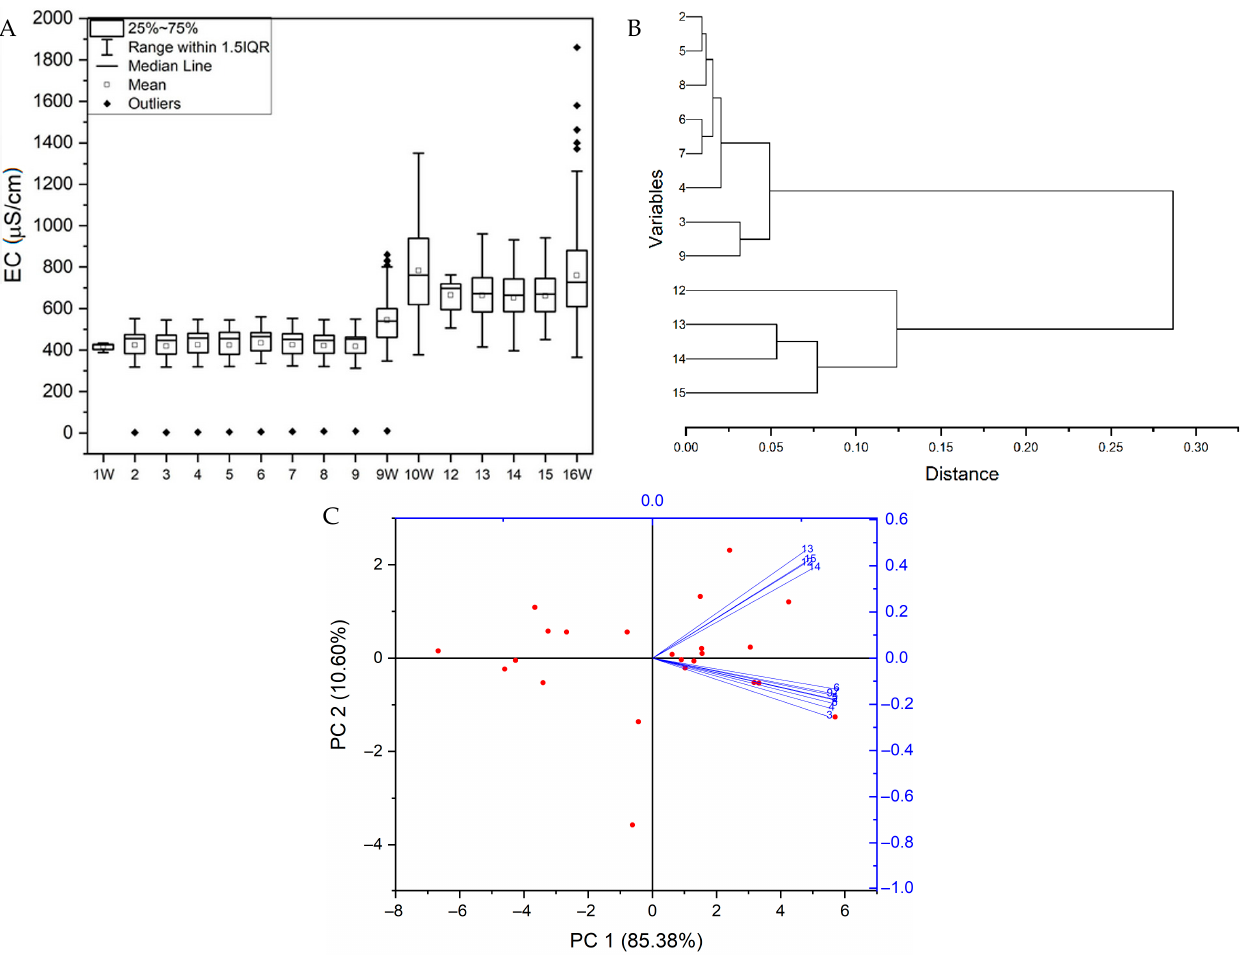
Figure 4. Statistical analyses of electrolytic conductivity (EC): boxplots ( 4A ; this research and WIO Ś ), HCA ( 4B ; this research), and PCA ( 4C ; this research).